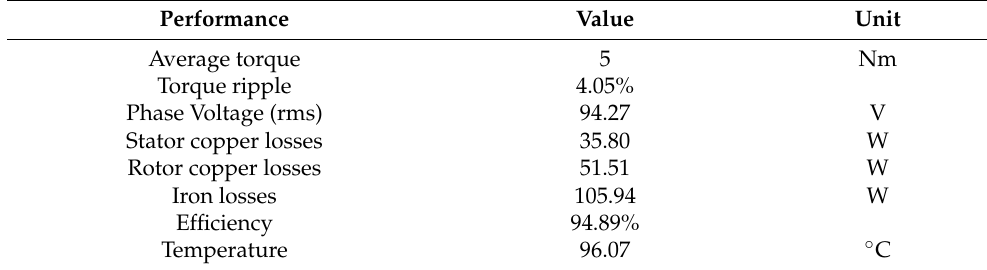
Table 6. Adjusted machine